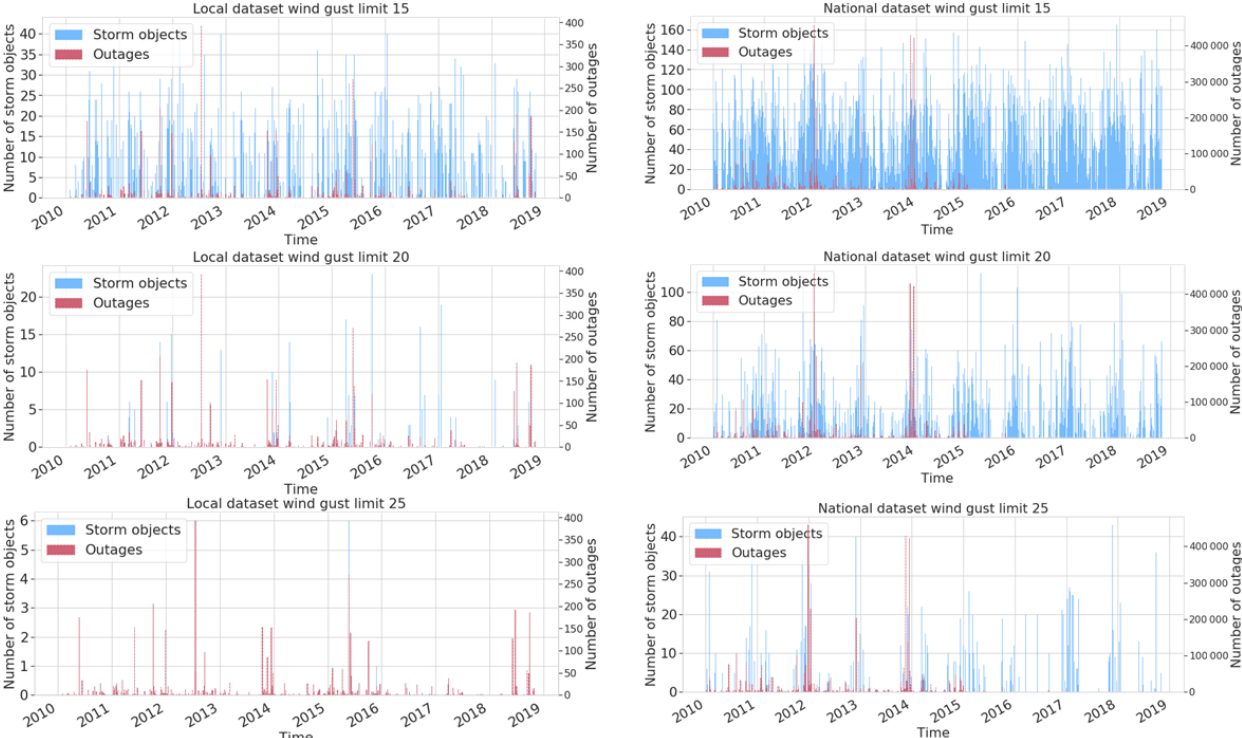
Figure 3. Storm object time series (15, 20, and 25ms − 1 contours) with occurred outages for local and national datasets.